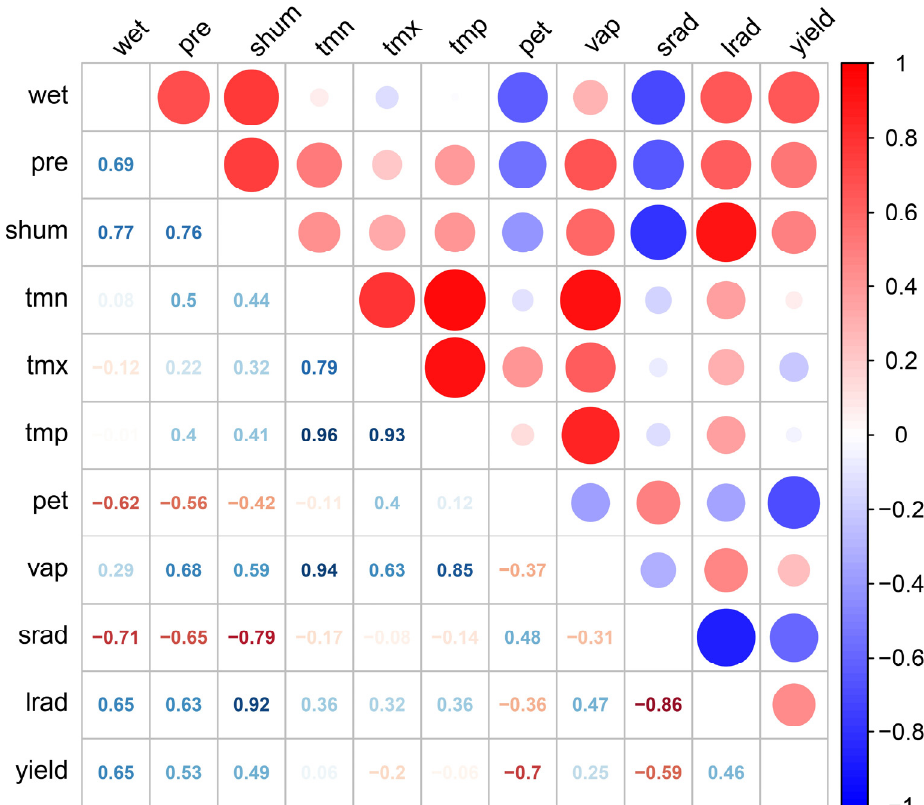
Figure 3. Correlations among the 10 climate variables and correlations between each climate variable and yield.